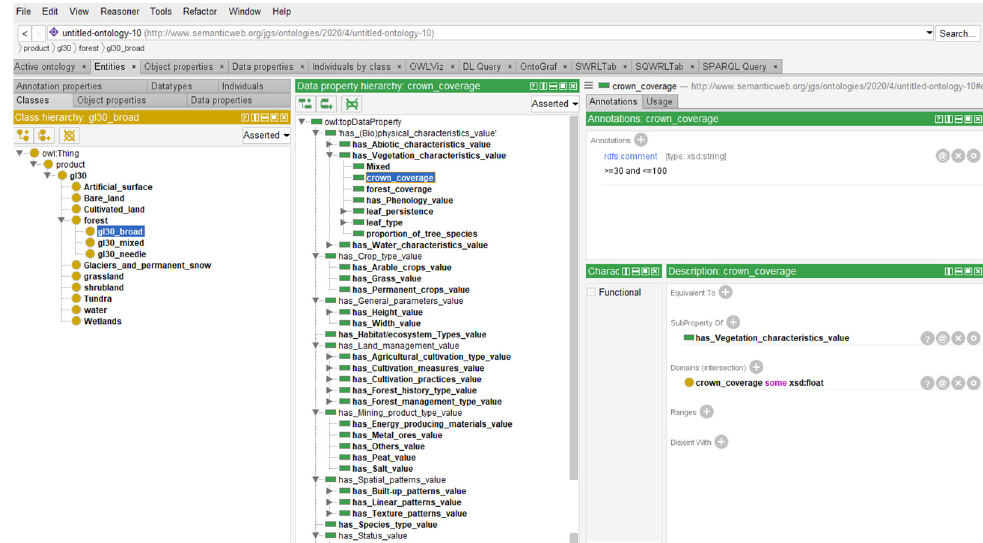
Figure 4. GlobeLand30 land-cover ontology.